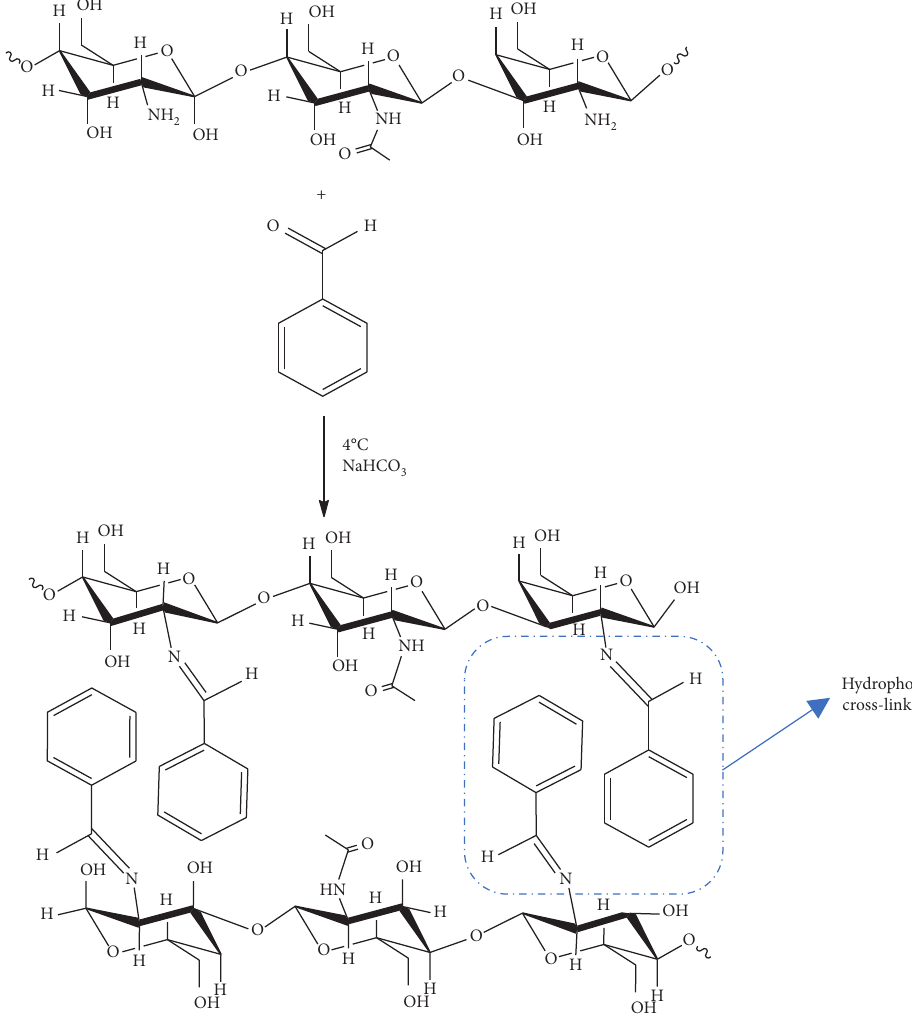
Figure 7: Schematic representation of the formation process of the physical hydrogel.